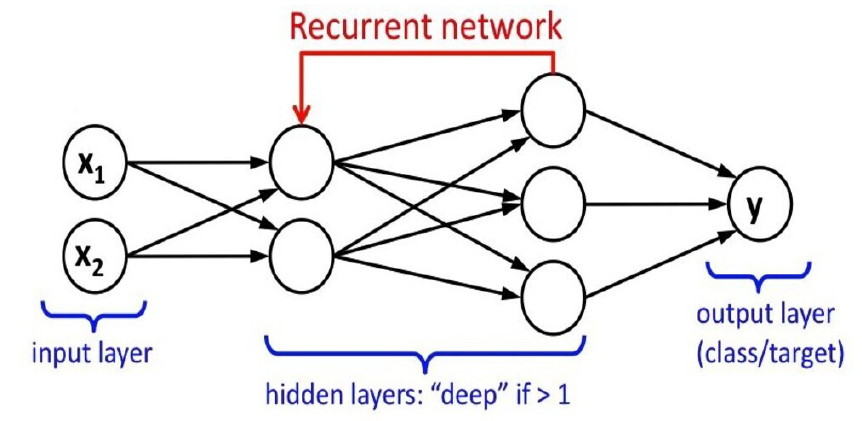
Figure 4. Recurrent Neural Network (RNN), representing the skeleton on which every RNN is built. The output of each layer acts as the input to the next and modifies the hyperparameters of the layer in each epoch, thus implementing the learning part of the algorithm.